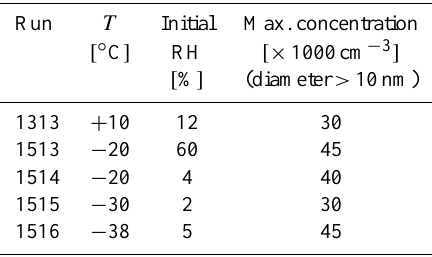
Table 2. SOA growth experimental conditions of the presented runs. Run